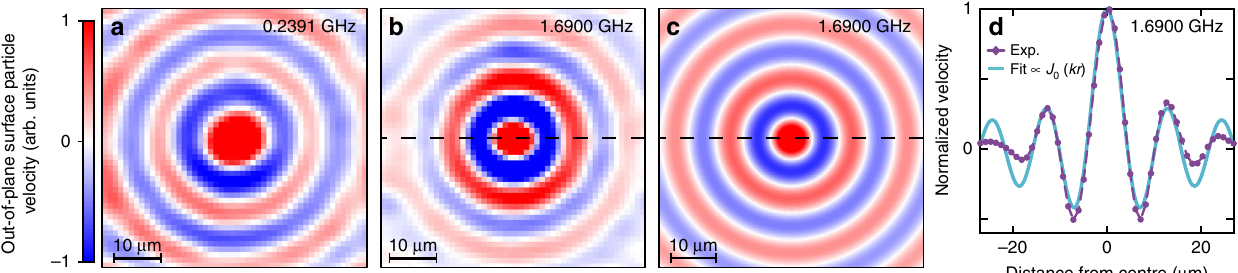
Fig. 2 Imaging a ZGV Lamb mode. a , b Normalized images of the measured out-of-plane surface particle velocity at a 0.2391 and b 1.6900 GHz. The x and y axis directions are shown in Fig. 1a. Animations are viewable in the Supplementary Movie 1. c 2D acoustic fi eld at 1.6900 GHz based on a fi t to a Bessel function J 0 ( kr ). d Normalized out-of-plane surface particle velocity evolution of the experimental (dots) and fi tted (solid line) data as a function of radial distance for a frequency of 1.6900 GHz (dashed lines in b and c